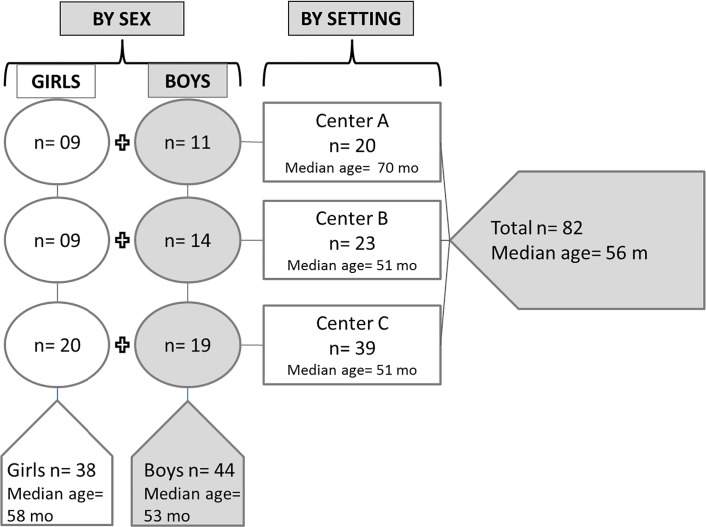
Characteristics of the Subjects, by setting and sex.